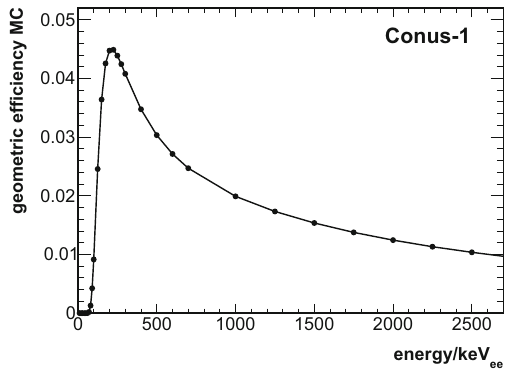
Fig. 3 Geometric detection efficiency curve of the MC simulation for γ -radiation. To determine the curve, a mono-energetic, isotropic γ -ray point source was simulated directly on top of the cryostat end cap. It becomes apparent that all radiation below ∼ 50keV ee is blocked by the cryostat, while the efficiency peaks at ∼ 200keV ee